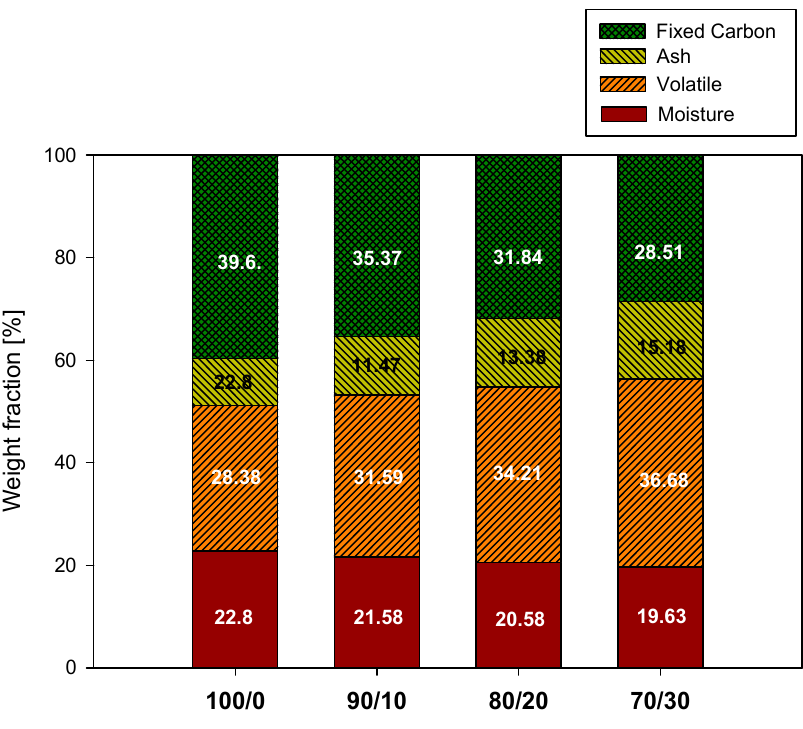
Figure 2. Proximate analysis of blended fuel.